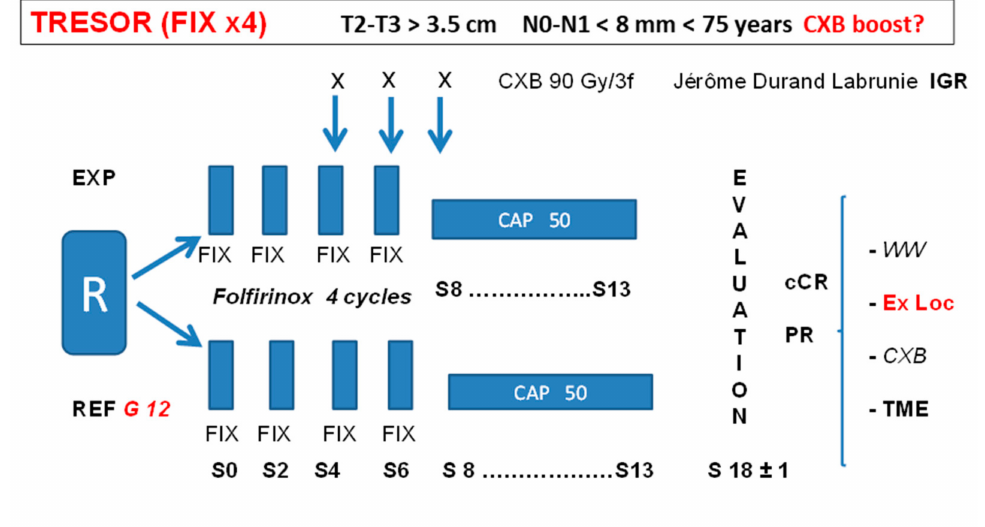
Figure 1. Illustration of CXB. ( Left ): The Papillon 50 TM system. Thick arrow: X-ray tube, also called Figure 4. Tentative TRESOR trial. a micronode. Plastic pipe (thin arrow) to circulate the mineral oil from the stand floor to the X-ray tube for anode cooling and allowing for a high dose rate (15 Gy/min). ( Upper right ): A treatment session. Patient in the knee–chest position. The rectal applicator is introduced in contact with the tumor under eye guidance and fixed (fisso arm). The X-ray tube is introduced into the rectal appli- cator to deliver the dose. ( Lower right ): Schematic drawing showing the X-ray tube introduced through the applicator in contact with the tumor. The FSD (focus surface distance is 4 cm). The focus is the anode (arrow) producing the 50 kV X-rays. Illustration of the dose distribution showing a sharp fall-off of the dose, which is 30 Gy at tumor surface (red) and 50% at 5 mm (green). There is nearly no dose to the rest of the rectal wall and surrounding tissues. It is a fully ambulatory treat- ment with good